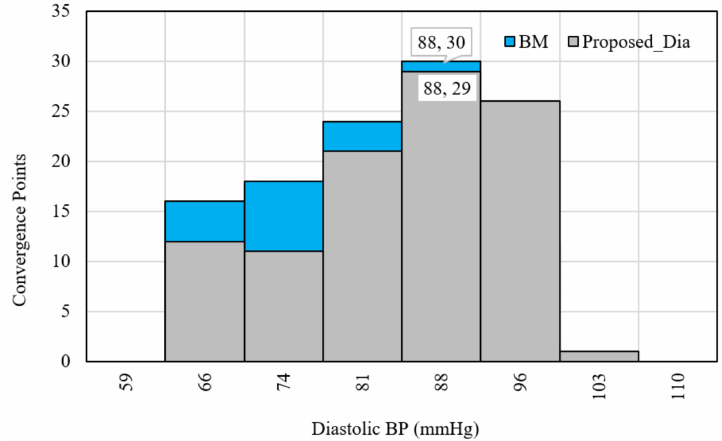
Figure 10. Histogram of the diastolic BP